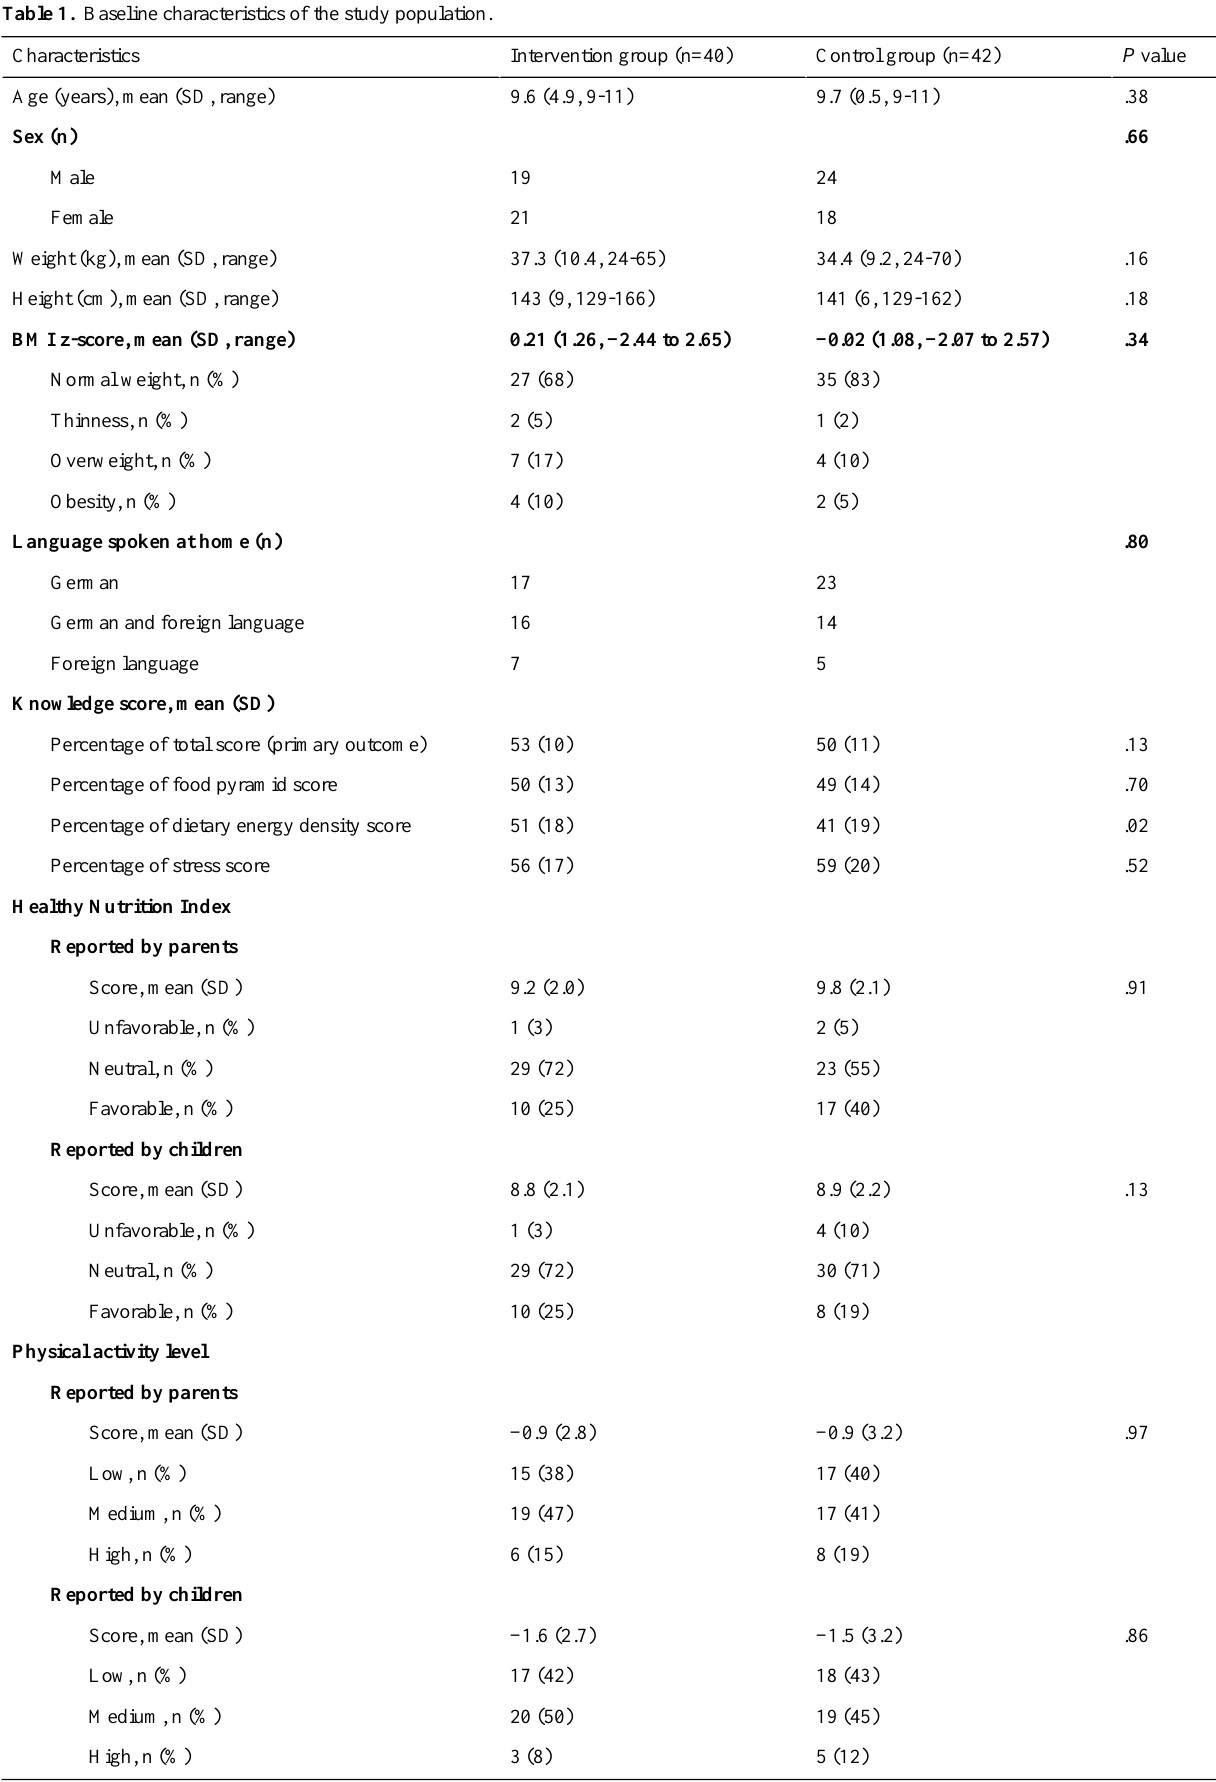
Table 1. Baseline characteristics of the study population.